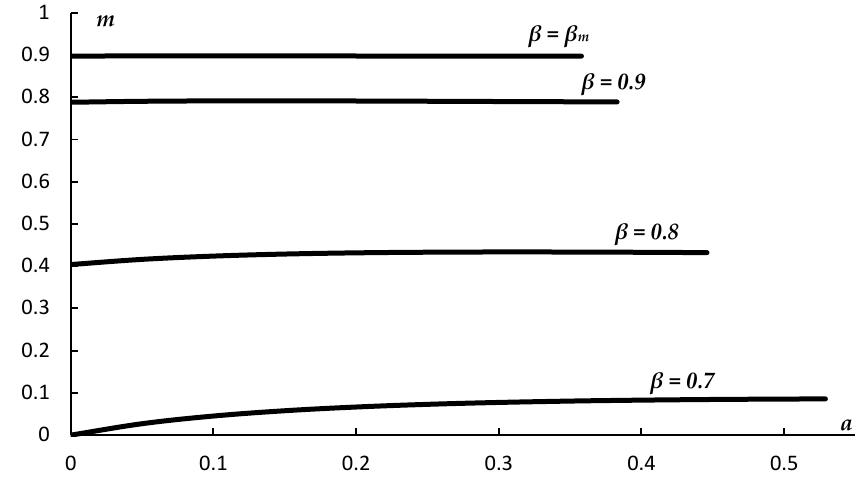
Figure 5. Variation of the dimensionless bending moment with a for several β values.